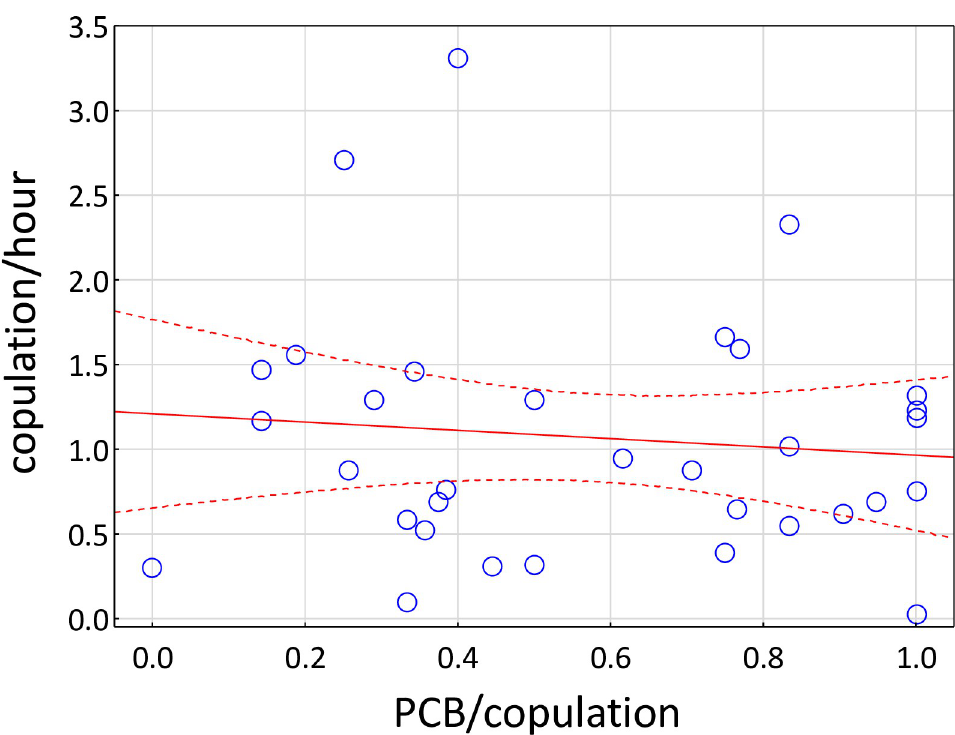
Fig 2. Frequency of copulation per female per hour by frequency of PCB (post-copulatory behavior) per female per copulation (blue circles represent individual females; r = -0.10; dashed lines = 95% confidence interval).